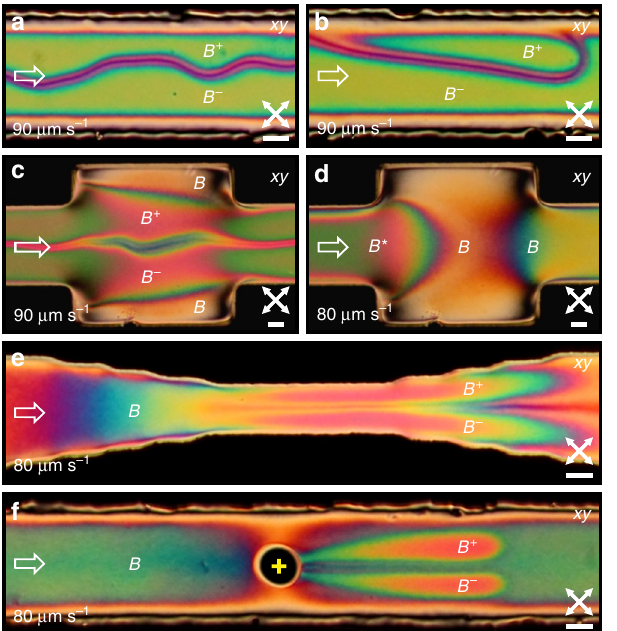
Fig. 2 Manipulation and stabilisation of chiral B ± states with channel geometry and laser tweezers. a Flow-stabilised achiral soliton is oscillating in the middle of the channel. b A droplet of oppositely handed domain is running along the side of the channel. c A wider square chamber, which B ± states have to breach to reach the other side. Note the increase of the soliton width inside the square chamber due to smaller fl ow magnitude.